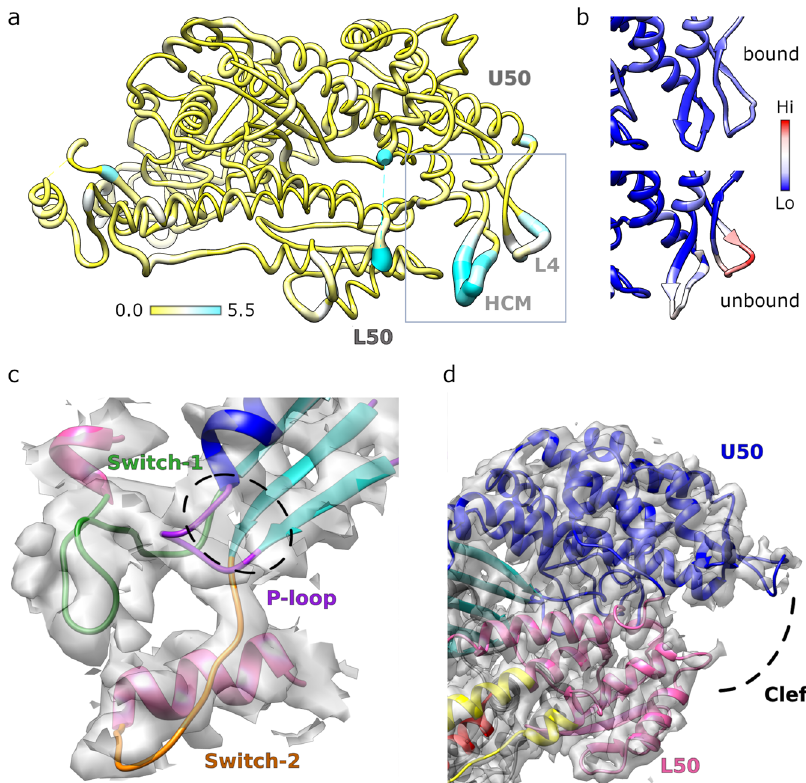
Fig. 2 Structure of the PfAct1-bound PfMyoA motor. a Atomic model of actin-bound PfMyoA motor domain with root mean square differences to the rigor-like unbound structure mapped in thickness and color, from 0 – 5.5 Å. Only residues present in both structures are shown. The hypertrophic cardiomyopathy loop (HCM), loop 4 (L4) and the upper and lower 50 kDa domains (U50, L50) are labeled. b Comparison of the normalized atomic temperature factors between the bound (upper panel) and unbound (lower panel) structures. The region shown corresponds to the box in A. c Density map and atomic model in the active site of PfMyoA shows without ambiguity the absence of nucleotide. There is no density in the cavity (black dashed lines) composed by the Switch-1 (green), Switch-2 (orange) and the P-loop (purple). d The density map and atomic model of the actin binding cleft located between the upper 50 kDa (U50, in blue) and the lower 50 kDa (L50, pink)